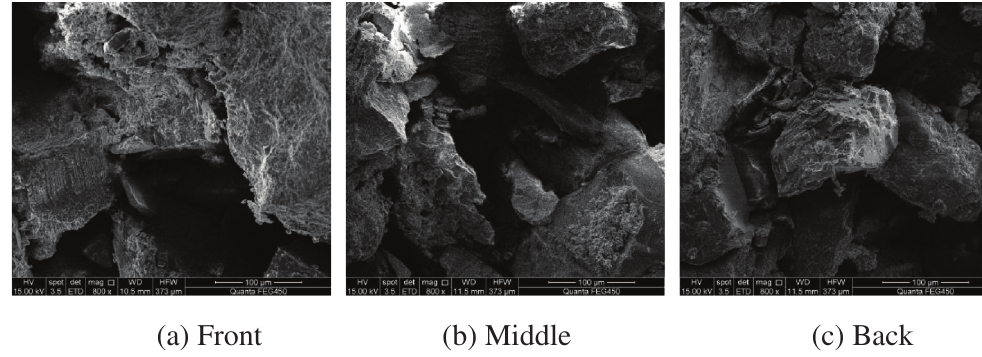
Figure 4: Morphology of core pore structure before gel flooding.